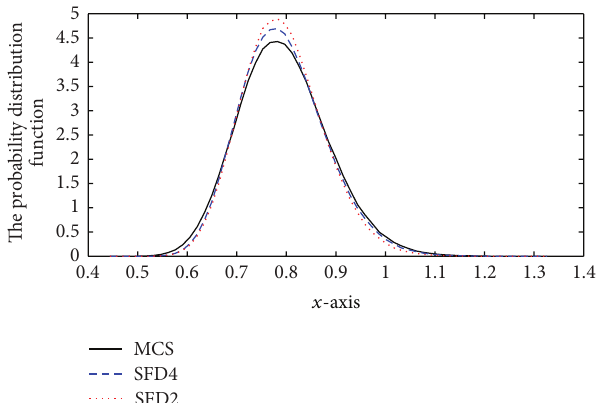
Figure 1: The pdf at point 𝐴 using SFDHC and MCS.